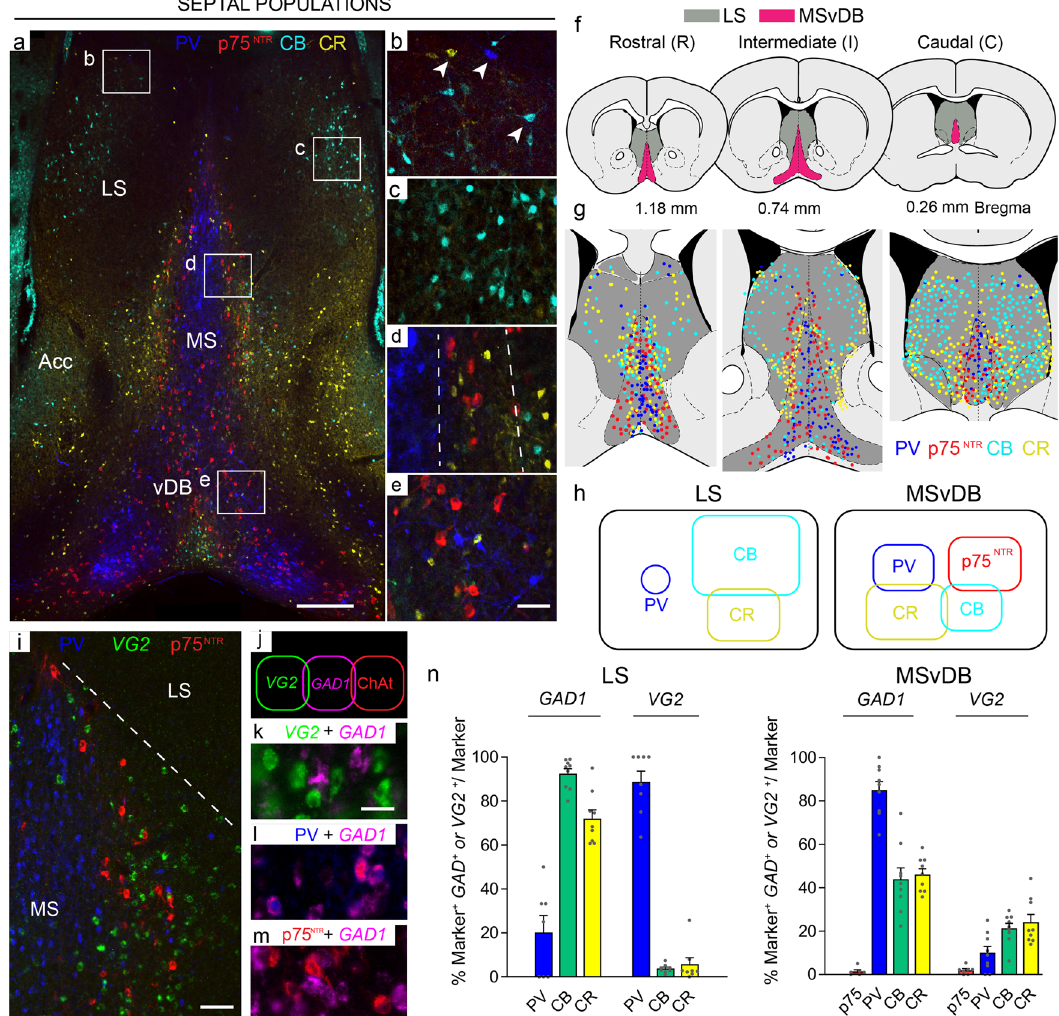
Fig. 1 Chemoarchitecture of the septal complex. a Representative coronal sections through the adult mouse brain showing the organisation of septal nuclei. The four main neuronal subpopulations examined in this study are: PV (blue), p75 NTR (red), CR (yellow) and CB (cyan). The picture was obtained by merging images from two consecutive sections. b – e Boxed areas in a are shown at higher magni fi cation: b , c LS; d MS; e vDB. b Immunoreactivity for the three calcium-binding proteins in non-overlapping neuronal populations throughout the LS (arrowheads). c CB-expressing neurons in the LS show the typical arrangement of a nuclear structure. d The laminar organisation of the MS is shown, dashed lines indicate the borders of the layers. e p75 NTR -, CB- and PV-immunoreactive neuronal populations are interspersed at the border of the MS and vDB. f Diagrams showing the three rostro-caudal levels analysed in this study. MSvDB and LS boundaries used in counts are shown (modi fi ed from ref. 71 ) and distribution of septal populations at rostral (R), intermediate (I) and caudal (C) levels. g Diagram showing relative abundance and overlap among the different populations of septal neurons at the three different levels examined in this study h Summary of the neuronal markers examined in this study and their overlap in the LS and the MSvDB. All overlaps indicated are <15%. i GABAergic (PV-expressing), glutamatergic and cholinergic neurons in the MSvDB. j MSvDB neurons expressing different neurotransmitters represent largely distinct populations. k – m Representative overlap between GABAergic, glutamatergic and cholinergic populations. n Quanti fi cation of co-localisation between GAD1 or VG2 cells and markers in the LS and MSvDB. n = 3 independent mice used for each marker. LS: GAD1 PV n = 7 sections; CB, CR n = 9 sections. VG2 PV, CB, CR n = 8 sections. MSvDB GAD1 p75 n = 6 sections; PV, CB, CR n = 9 sections. VG2 p75 NTR n = 7 sections; PV, CB, CR n = 9 sections. Histograms show mean + SEM. Source data are provided in Supplementary Data 1. LS lateral septum, MS medial septum, Acc shell of the nucleus accumbens, vDB vertical limb of the diagonal band. Scale bars: a 200 μ m, e , i 50 μ m, k 10 μ We examined the neurotransmitter phenotype of septal p75 NTR , (26.17 ± 3.8) MSvDB neurons co-express VG2 (Fig. 1n). Only PV, CB and CR neurons by quantifying their co-expression of GAD1 ( Gad67 ) and VG2 , markers that detect inhibitory and excitatory neuronal phenotypes, respectively. In the LS, the majority of CB + ve and CR + ve cells co-express GAD1 (92.5 ± 2.3%, and 70.3 ± 4.7%, respectively), whereas nearly all LS PV + ve neurons express VG2 (94.2 ± 3.3%; Fig. 1n). In contrast, PV + ve neurons in the MSvDB are GABAergic (95.8 ± 4.2%), as are some CB + ve and CR cells + ve (43.9 % ± 5.2%, and 46.12 ± 2.6%, respectively). Small numbers of PV + ve (7.6 ± 3.3%), CB + ve (21.3 ± 2.3%) and CR + ve